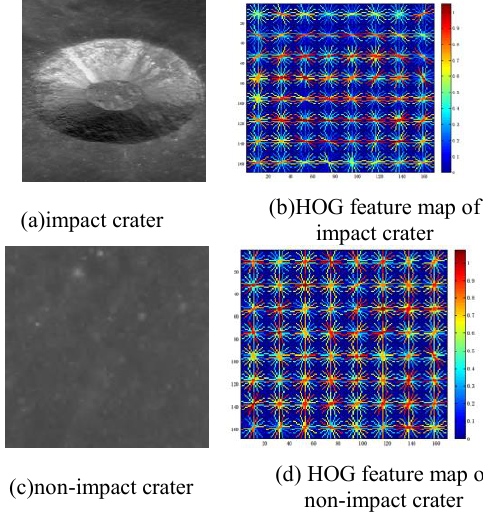
Figure 3 HOG feature map of impact crater and non-impact